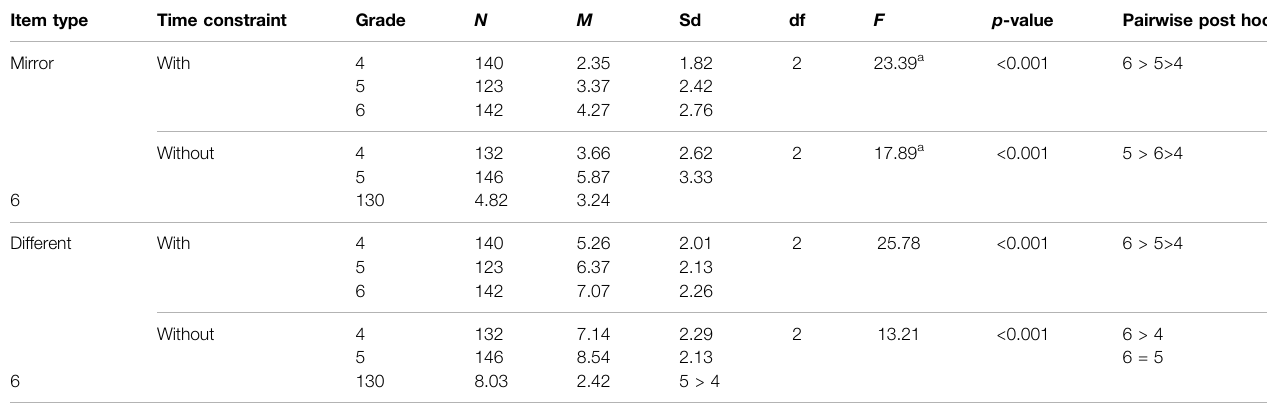
TABLE 5 | Grade difference by time constraint and item type.